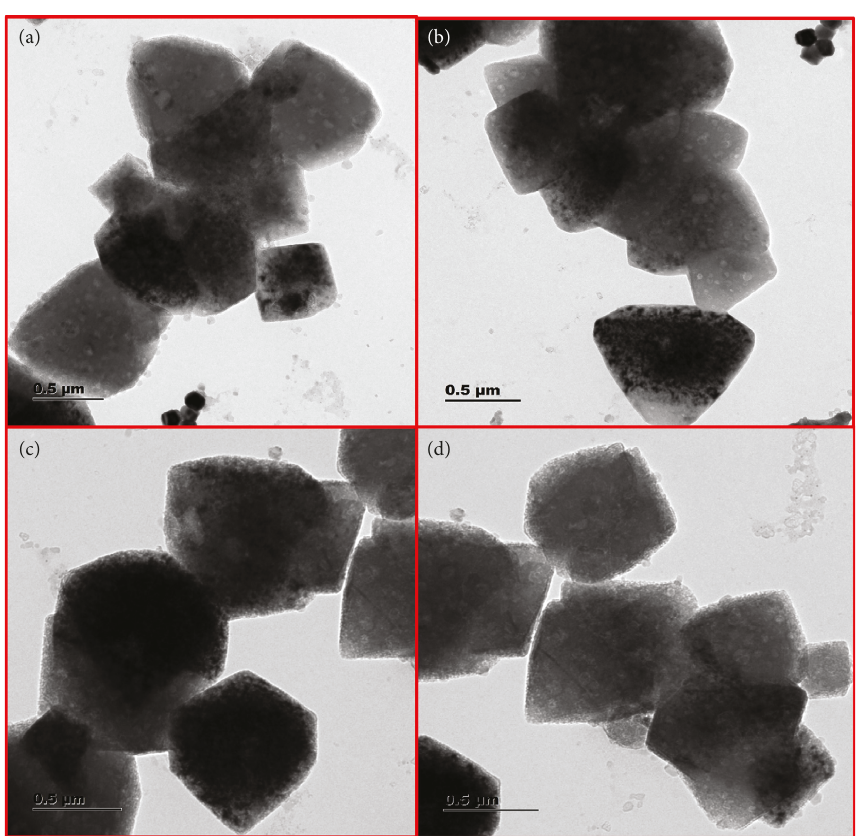
Figure 4: TEM image of the La